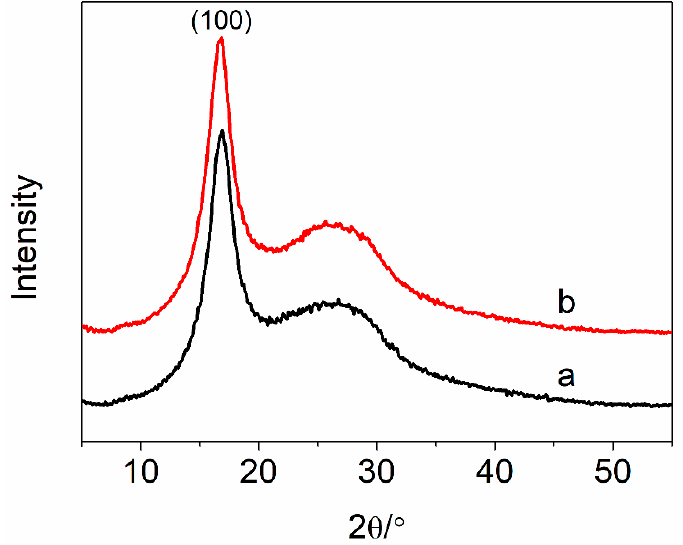
Figure 6. XRD curves of ( a ) the PAN nascent fibers and ( b ) the grafted MWCNT/PAN nascent composite fibers. Table 1. XRD data for the PAN nascent fibers and the grafted MWCNT/PAN nascent composite fibers.